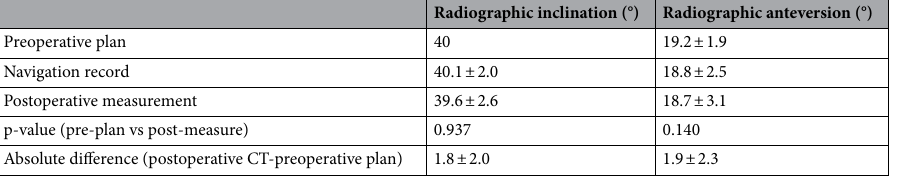
Table 2. Results of average cup angles.